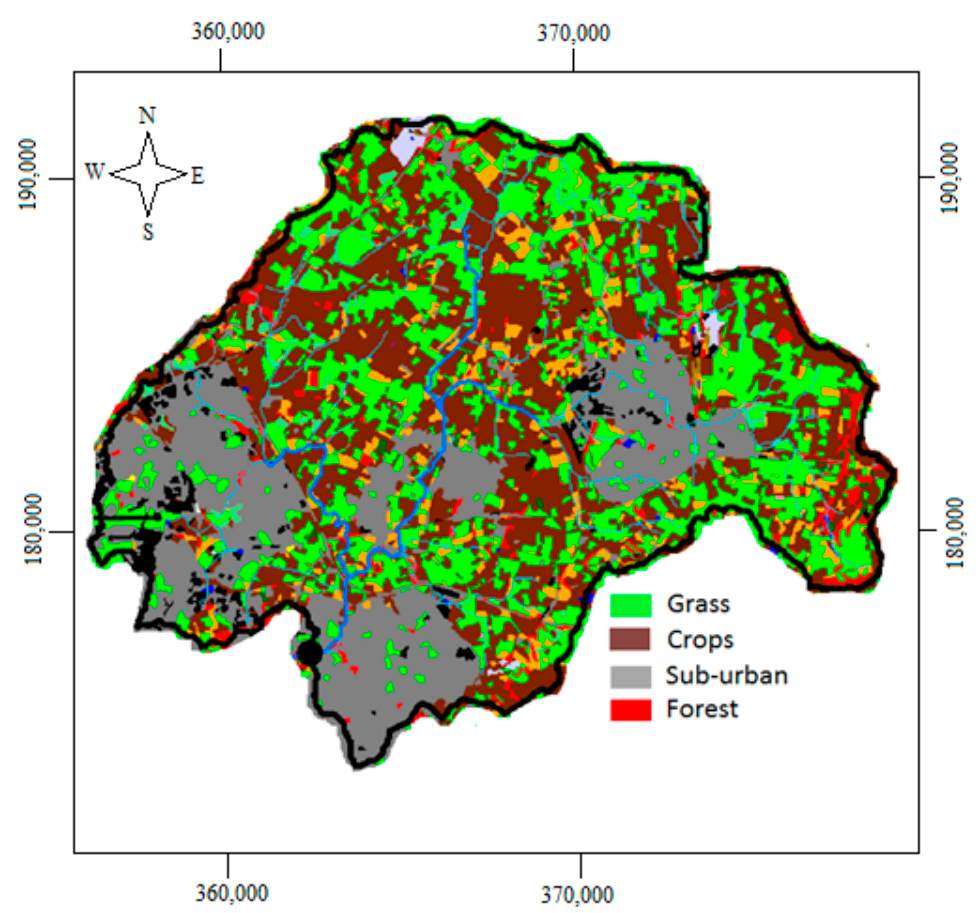
Figure 2. Key land use types in the Frome catchment.